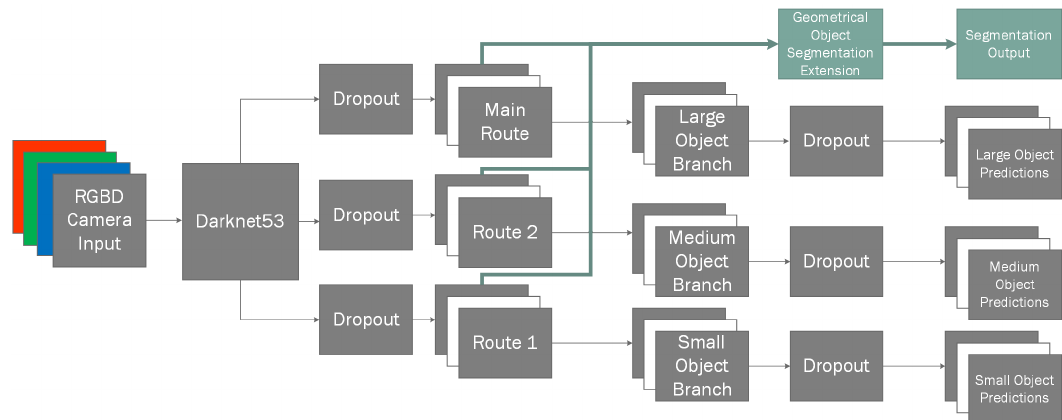
Figure 1. Our extended YOLOv3 capable of extracting geometric object segmentation along with object bounding